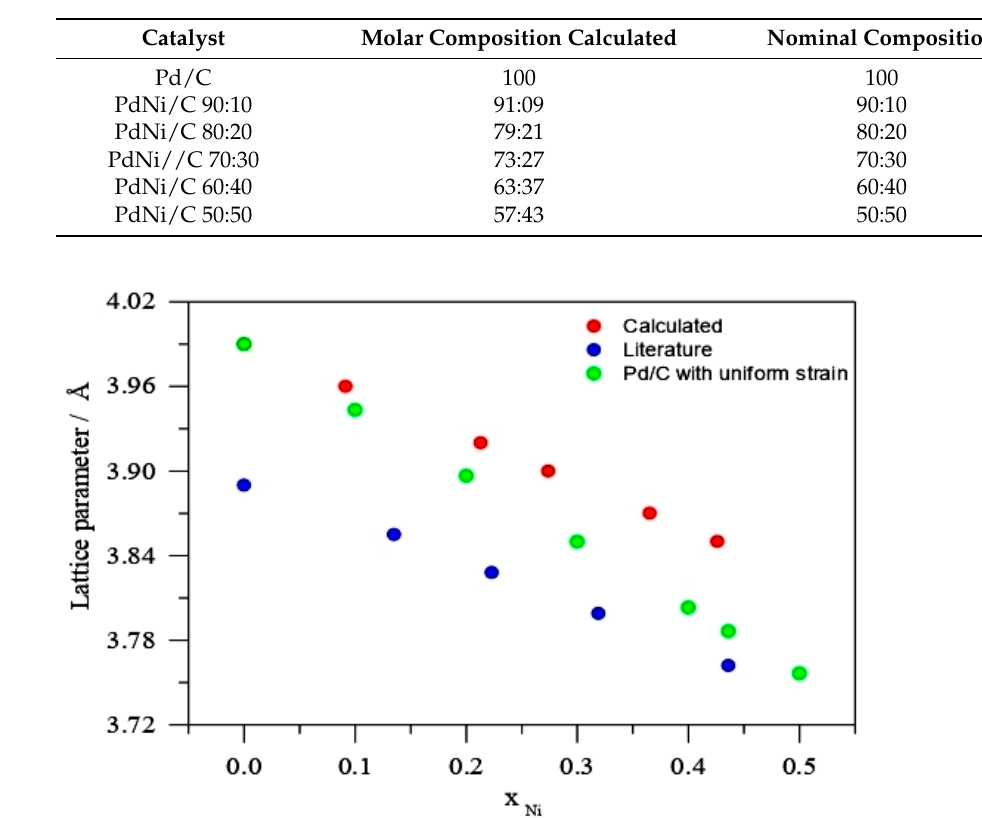
Figure 3. Lattice parameter against Ni molar fraction calculated from Equation (5), Reference [19] and calculated Pd uniform strain a (3.970 Å). and calculated Pd uniform strain a 0 (3.970 0 Table 2. Molar composition of Pd/C and PdNi/C nanocatalysts derived from XRD data.